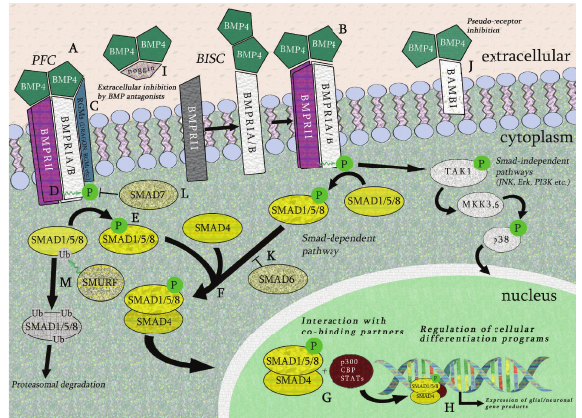
Figure 1: General BMP4 cellular signalling pathway. BMP4